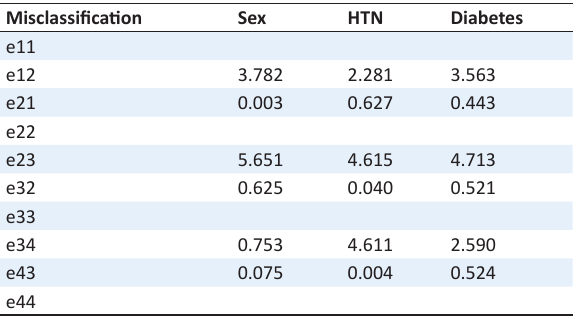
Table 7. Odds ratios for misclassification probabilities under categorical variable Misclassification